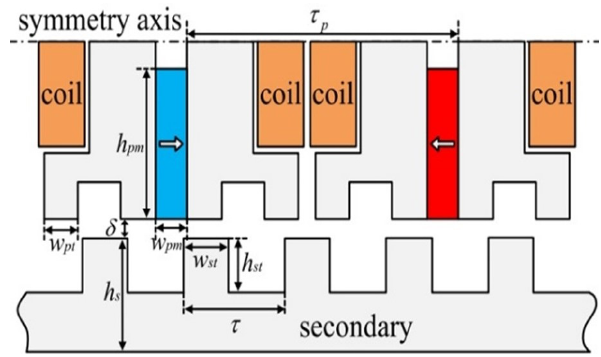
Figure 2. Structure and parameters of the proposed dual mover yokeless multi-tooth PMFSM.